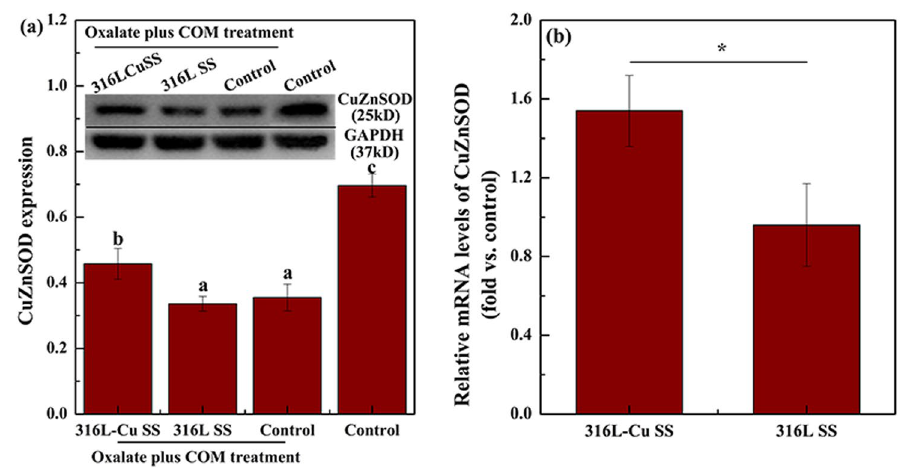
Figure 3. 316L-Cu SS activated the expression of CuZnSOD of UECs. ( a ) Expression of CuZnSOD and ( b ) qPCR analysis of the CuZnSOD-related gene expression for UECs. Cells were seeded on the surfaces of 316L- Cu SS and 316L SS. DMEM containing oxalate (2 mM) and COM (200 μ g/ml) was used to induce cell injury. After incubating for 24 h, the cells were harvested and used for western blot analysis. Anti-GAPDH antibody was used to evaluate equal protein loading on the blot. The density of the bands and relative mRNA levels were expressed as the fold difference from the housekeeping protein and gene, respectively. Then, the levels were calculated relative to the control, which was given the same treatment. Values are presented as the mean ± SD (N = 3). A significant difference at p < 0.05 is shown with different letters * p < 0.05. Intact western blot results can be seen in Supplementary